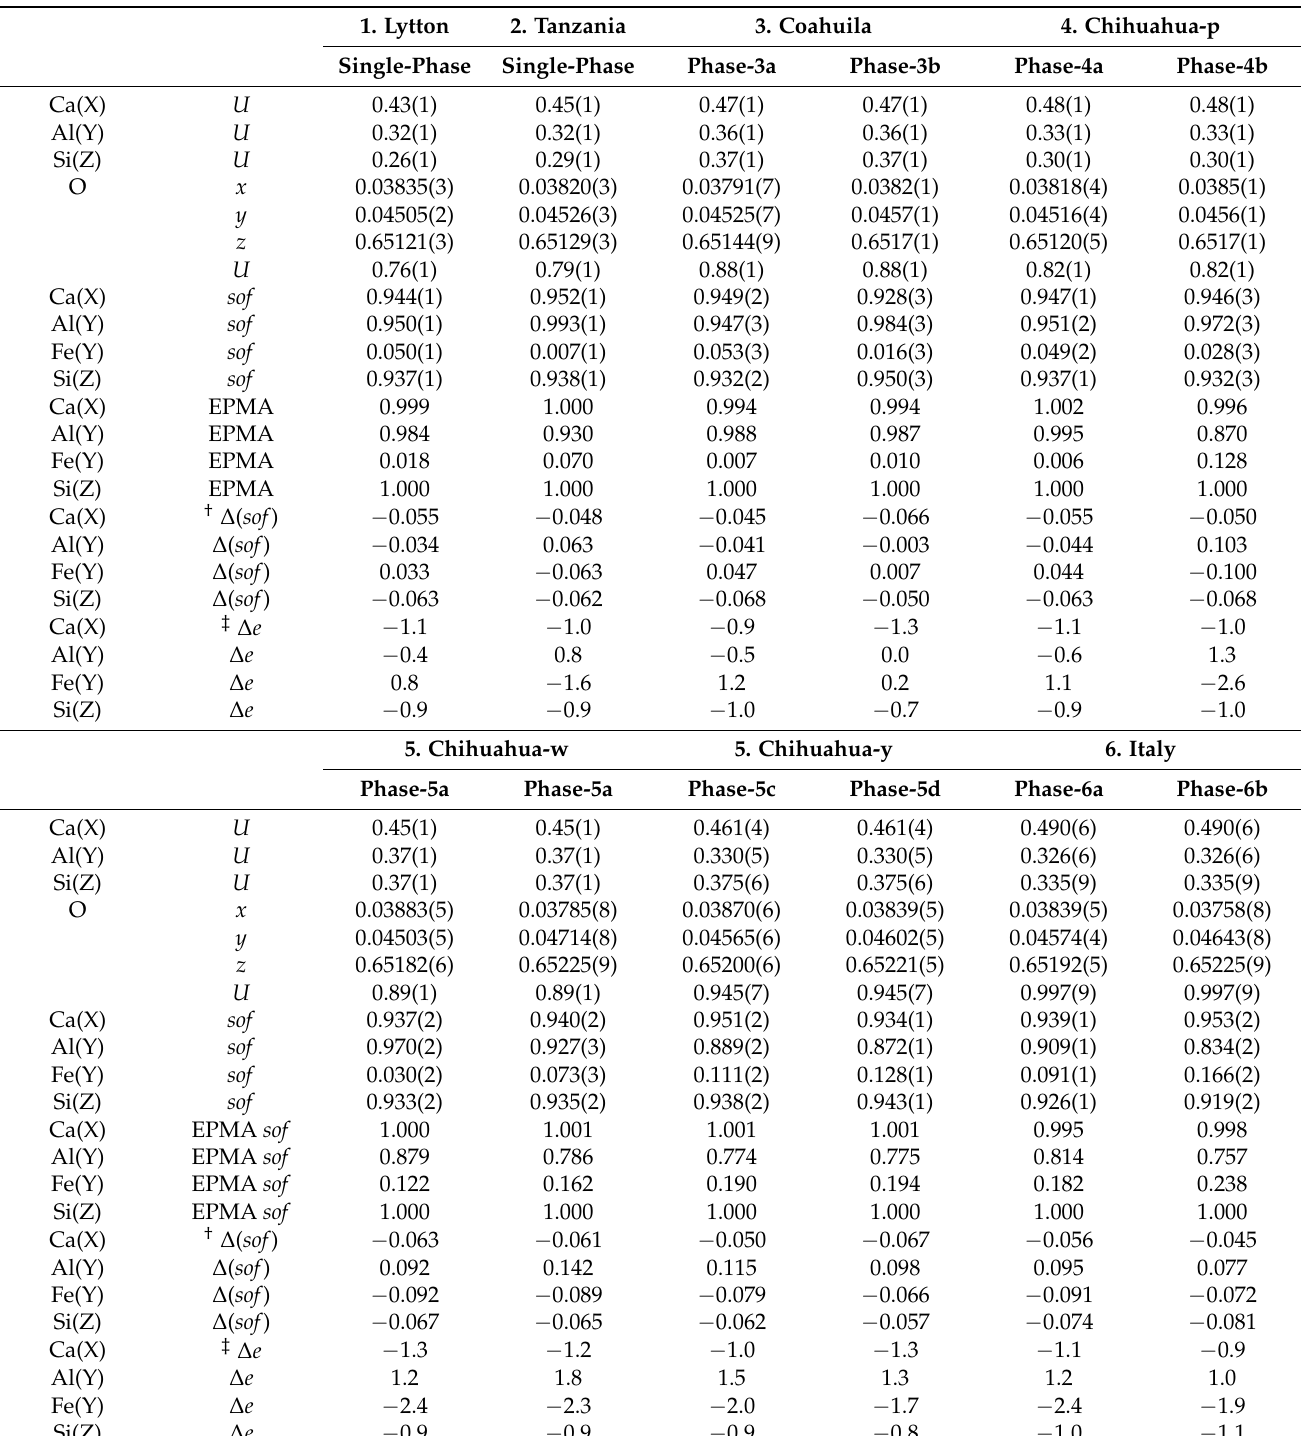
Table 3. Atom coordinates *, isotropic displacement parameters, U × 100 (Å 2 ), and sofs for six grossular